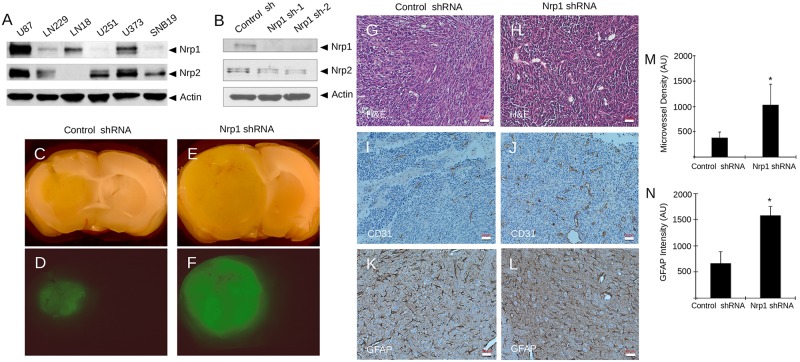
Genetically targeting NRP1 leads to enhanced GBM growth and progression in vivo.(A); Immunoblot analyses of detergent-soluble lysates from six different human GBM cell lines reveals varying levels of Nrp1 and Nrp2 protein expression. (B); RNAi-mediated targeting of NRP1 in LN229 GBM cells with two different lentiviral-expressed shRNAs leads to reduced expression of Nrp1 protein, but not Nrp2 protein, as revealed by immunoblotting. (C-F); LN229 cells stably expressing control (non-targeting) shRNAs (C, D) or shRNAs targeting Nrp1 (E, F) were injected intracranially (n = 5 mice per cell type) and brain tumor xenografts were subsequently analyzed by bright field (C, E) and GFP fluorescence imaging (D, F). Note the obvious Nrp1-dependent differences in tumor size in the representative images. (G-L); Analysis of Nrp1-dependent angiogenesis and reactive gliosis in brain tumor xenografts by H&E staining (G, H), anti-CD31 (I, J) and anti-GFAP (K, L), respectively. Scale bars, 20 μm. (M, N); Quantitation of blood vessel densities based on CD31 expression (M) and tumor-associated astrocyte based on GFAP expression (N) in brain tumors generated from LN229 cells expressing control shRNAs or Nrp1 shRNAs, *p<0.05 for Nrp1 shRNA tumors in comparison to control shRNA tumors. All error bars represent standard deviation.